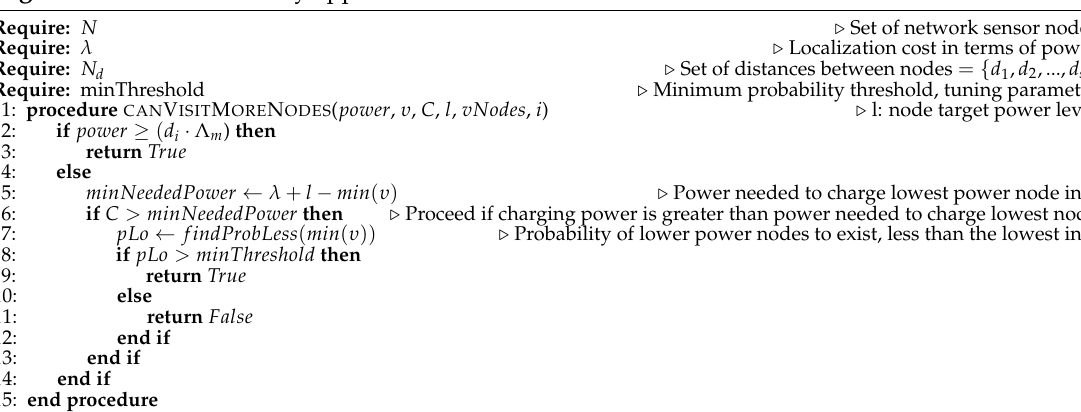
Algorithm 4 Minimum Only approach for CAN V ISIT M ORE N ODES